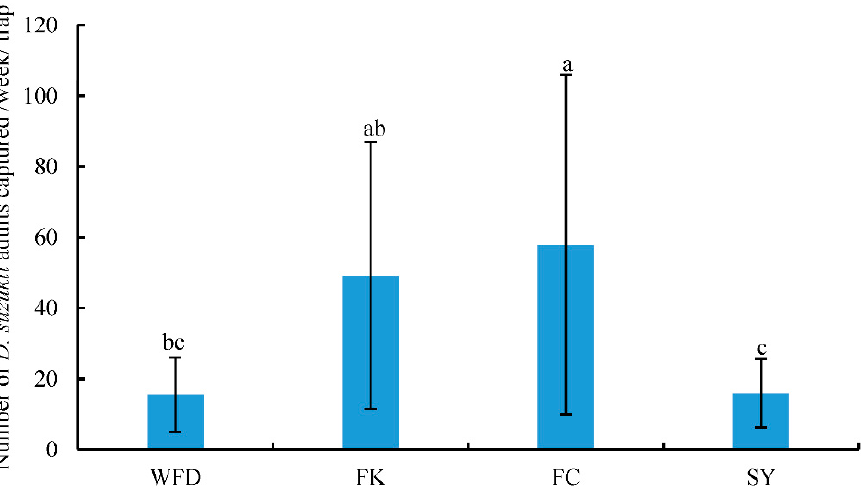
Figure 3. Number (mean ± SE) of D. suzukii adults captured per week per trap at different locations. Different letters above the bars indicate a significant difference between locations ( p < 0.05, LSD). Among the survey locations, the sex ratio of D. suzukii adults captured was not significantly different and ranged between 55% and 65% (WFD: 62.06%, FK: 62.18%, FC: 59.69%, SY: 58.65%) (Figure 4, Supplementary Data S1) (F = 0.073, df = 3, 37, p > 0.05).